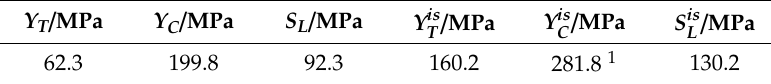
Table 1. Strength values of CFRP IM7 / 8552